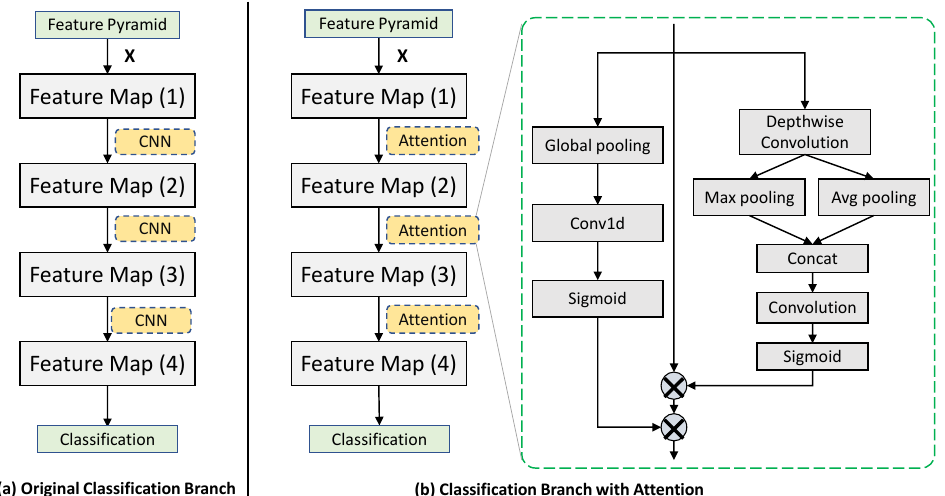
Figure 4. The comparison of ( a ) original classification branch and ( b ) modified classification branch with stacked dual attention. In ( a ), the standard convolutional layers are used. In ( b ), three standard convolutional layers are replaced by the three stacked dual attention